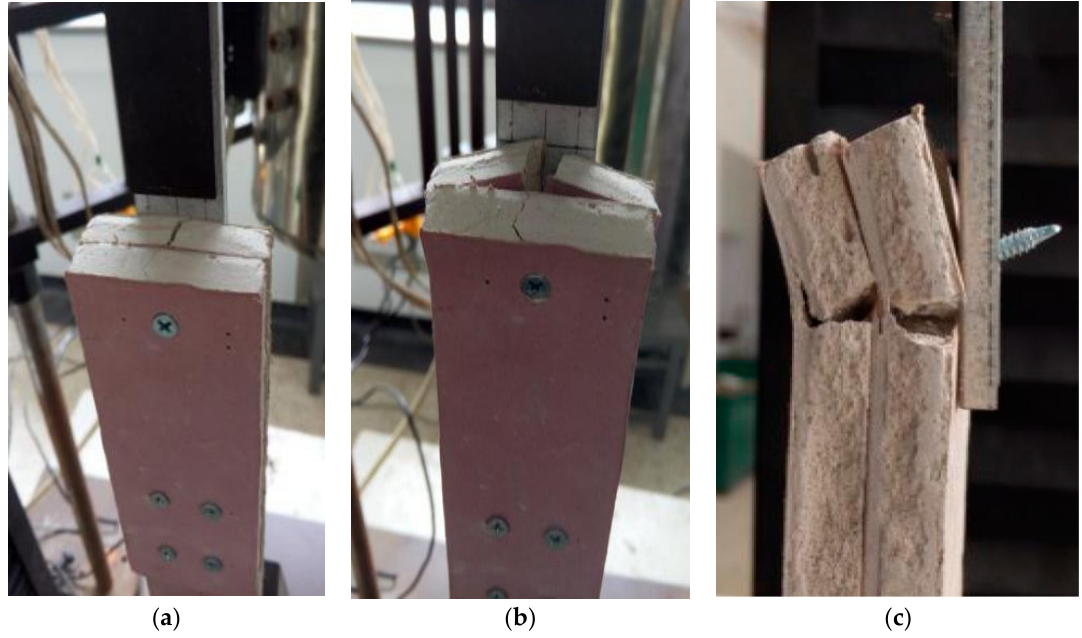
Figure 7. The failure process of GPB20D ‐ 20: ( a ) cracking of the base layer gypsum plasterboard on the loaded edge; ( b ) failure of the base layer gypsum plasterboard; and ( c ) B + T + F failure.